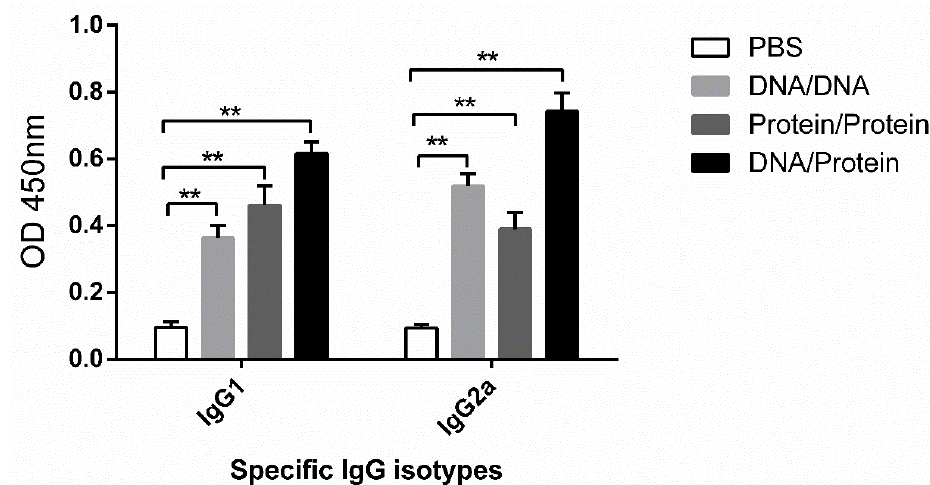
Figure 4. Levels of IgG1 and IgG2a subtypes of IgG antibody in serum of mice after vaccination. The serum of each group of mice was collected 14 days after the booster immunization, and the levels of IgG1 and IgG2a subtypes were evaluated by indirect ELISA. Each group of data is expressed as mean ± standard error ( n = 10). The absorbance value was measured at OD 450nm . ** p < 0.01.